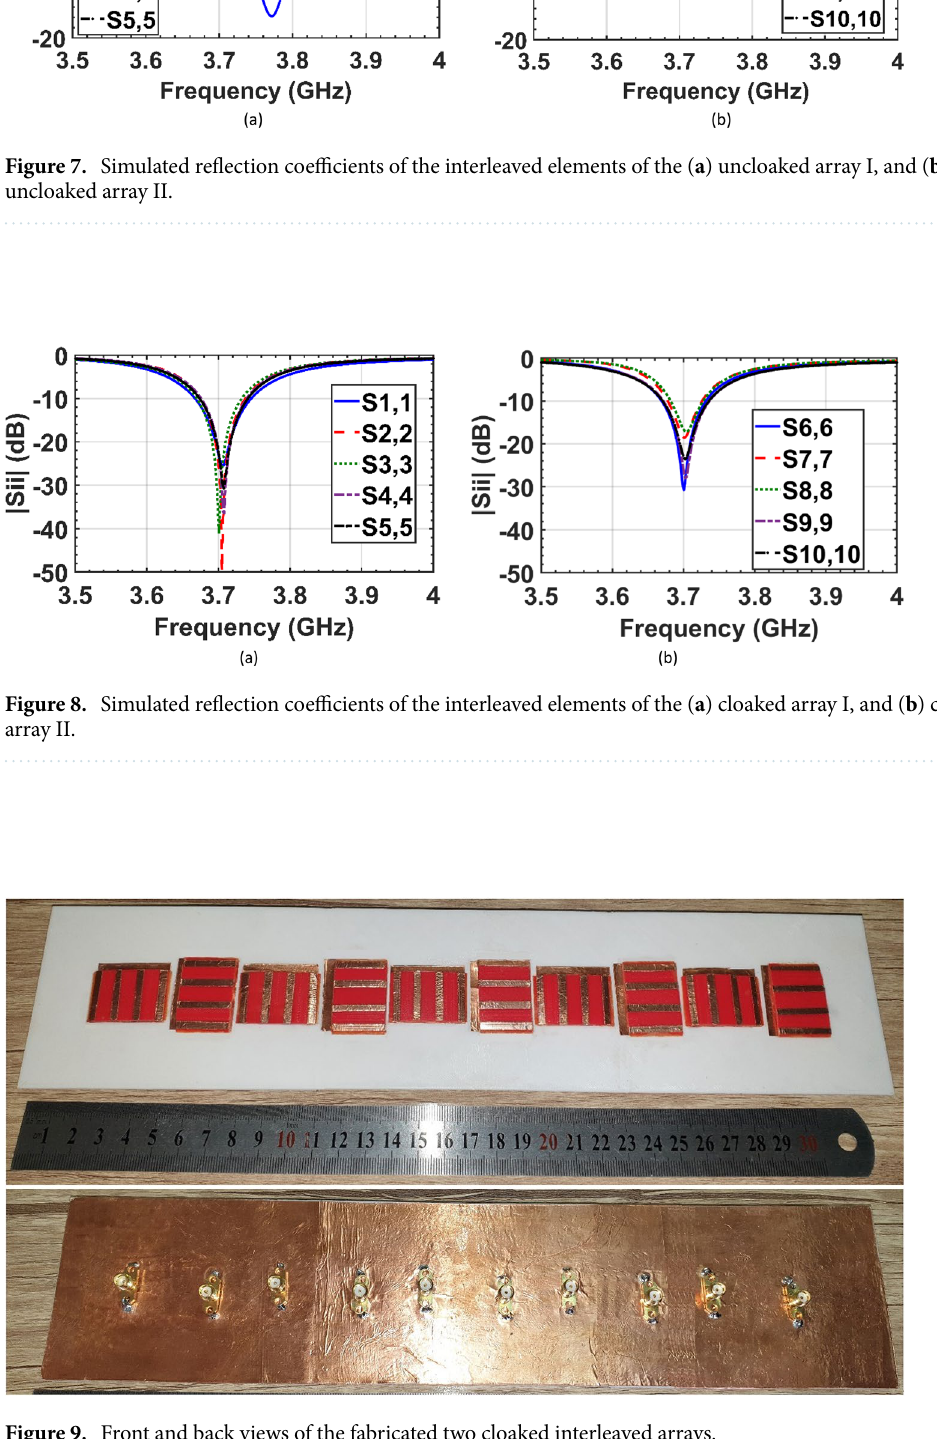
Figure 9. Front and back views of the fabricated two cloaked interleaved